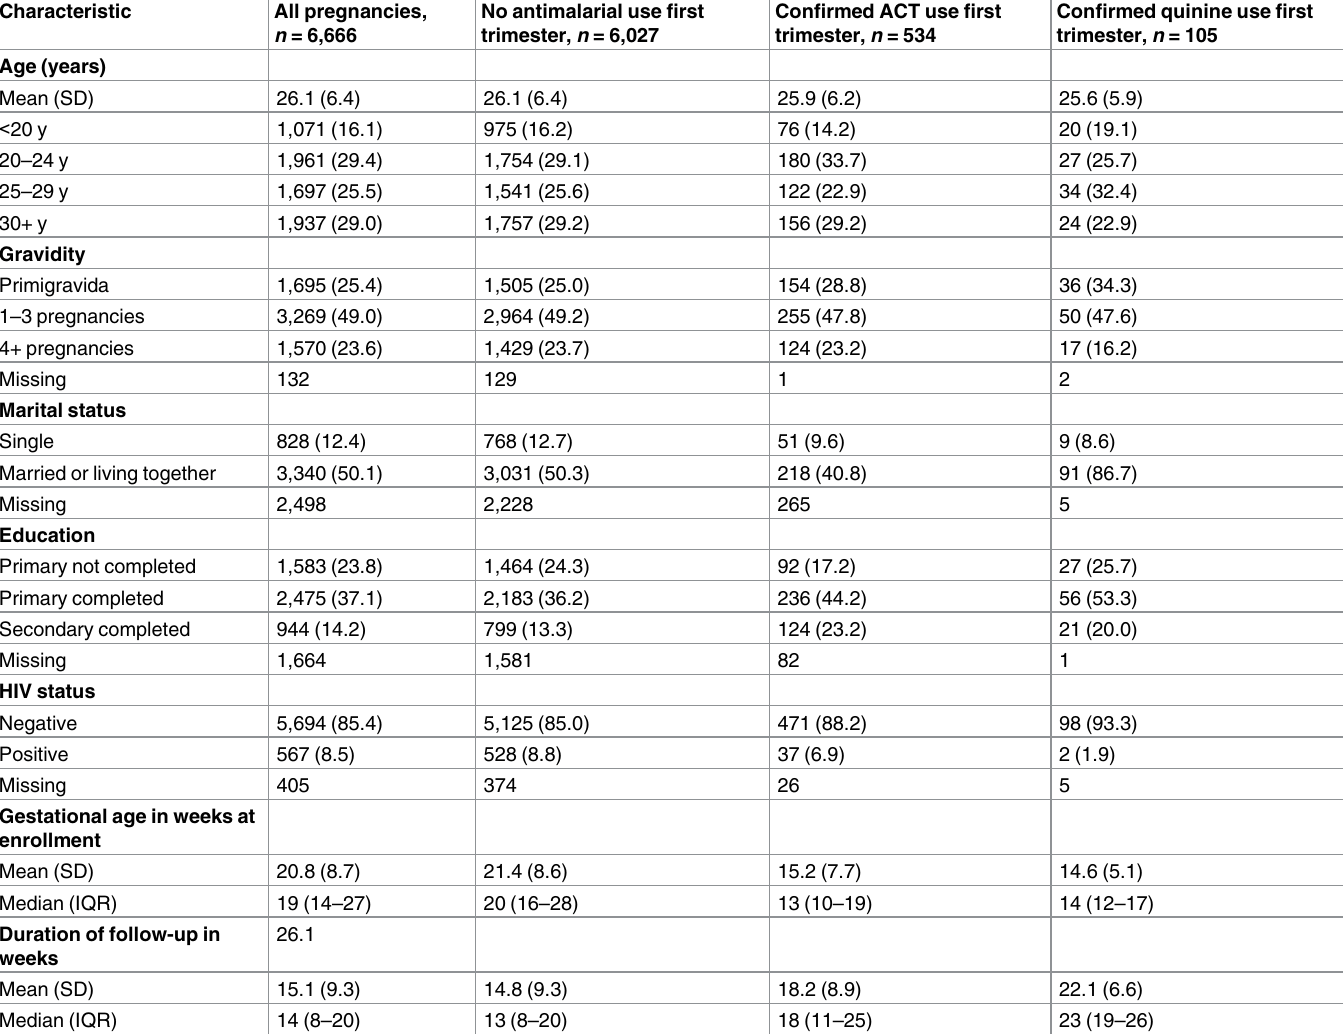
Table 2. Descriptivecharacteristics of pregnancies across exposure categories for the African sites contributing to the individual patient data meta-analysis. Characteristic All pregnancies, No antimalarial use first n = 6,666 trimester, n =